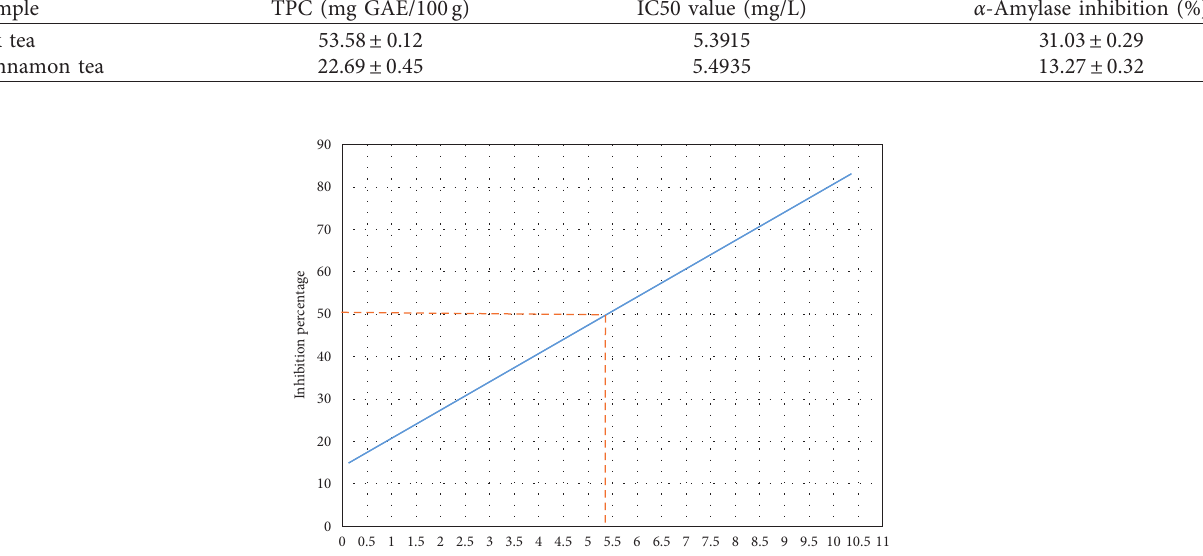
Table 3: Total polyphenolic content, IC50 value, and alpha-amylase inhibition assay of Jak tea and cinnamon tea. Sample